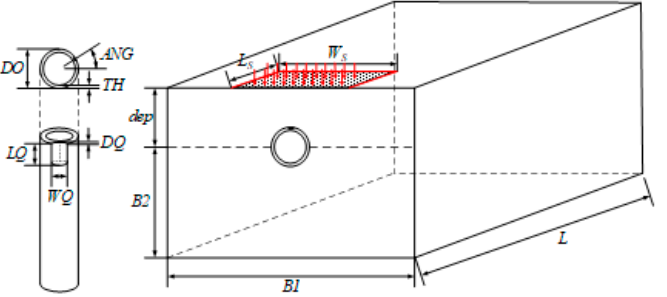
Figure 3. Schematic drawing of finite element model of pipeline with defects under surface load.